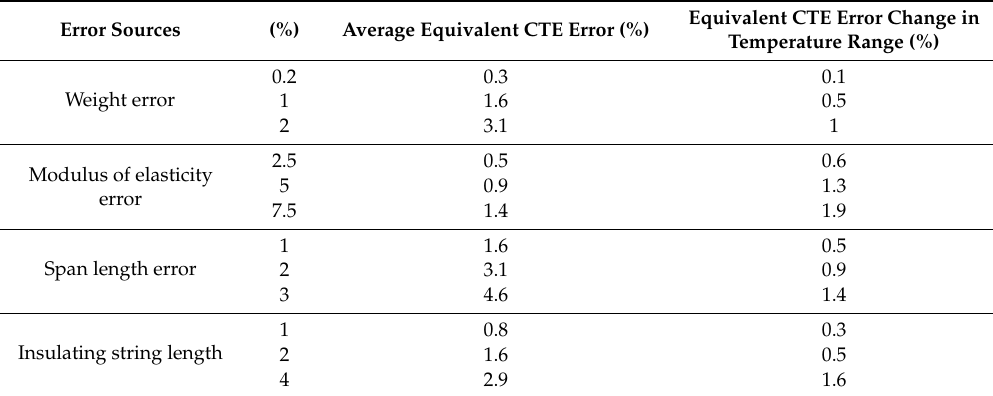
Table 4. Equivalent CTE error.